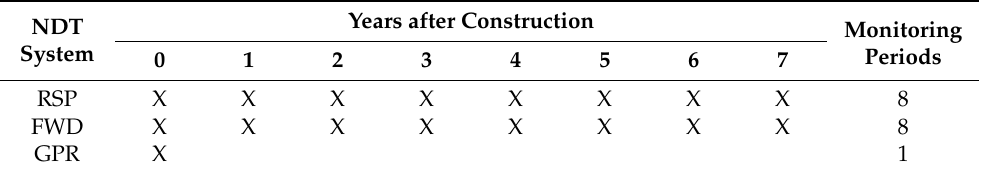
Table 2. Monitoring